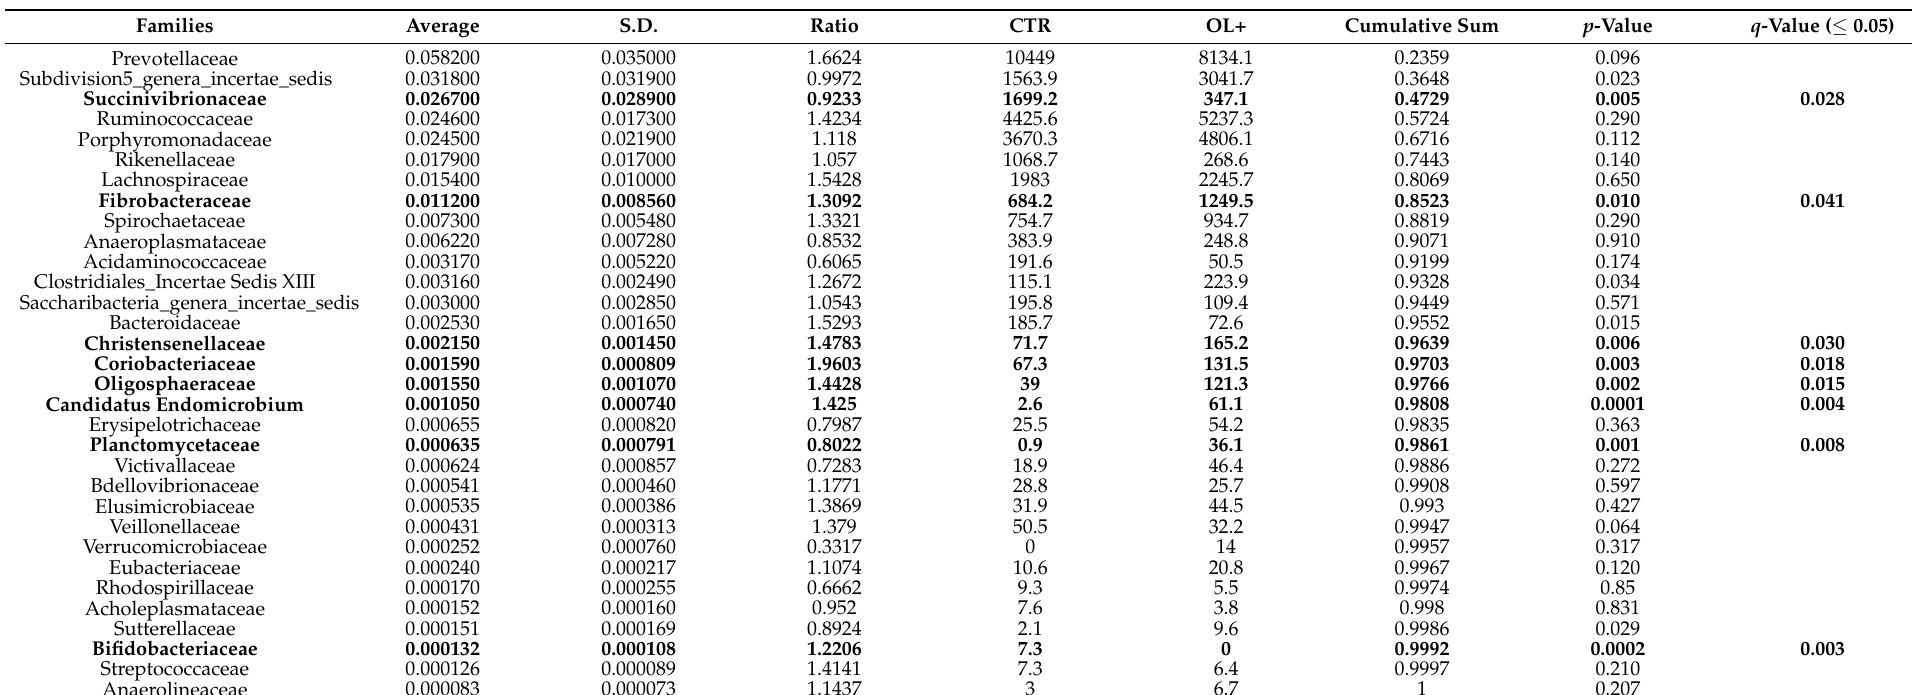
Table 4. SIMPER-generated family list ordered by percentage contribution to Bray-Curtis dissimilarity and families of which abundances significantly differ between two groups (OL+ vs CTR) based on Kruskal–Wallis